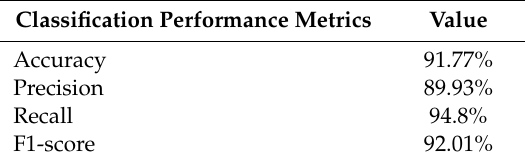
Figure 11. Top 10 features of Windows binary. Table 10. Classification Performance of Windows Binary.